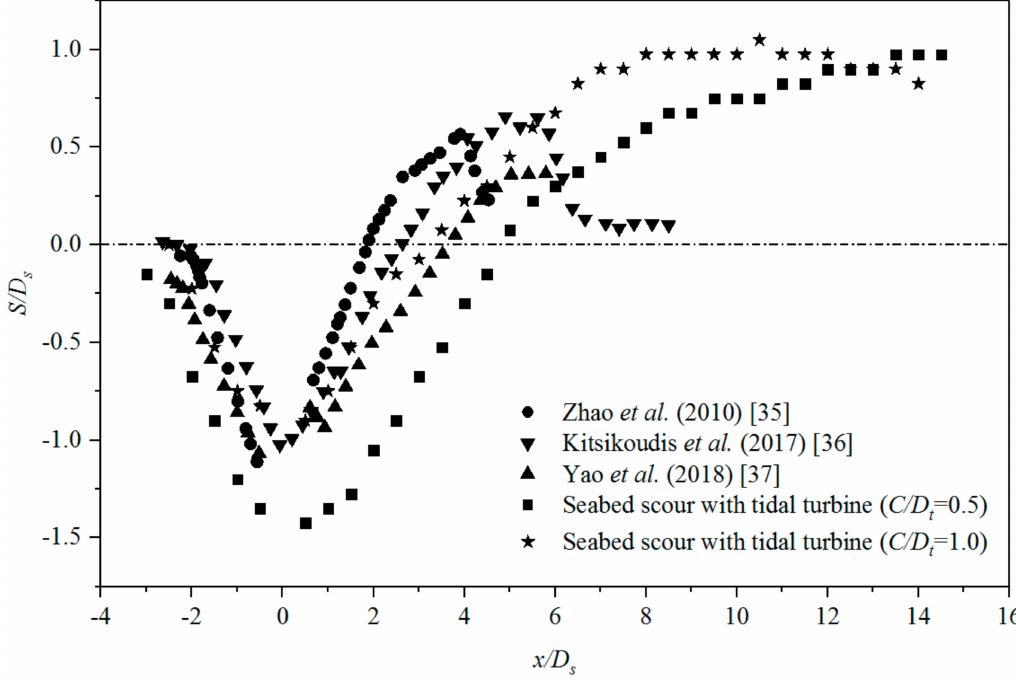
Figure 11. Tidal turbine scouring and cylinder scouring. Table 4. Comparison of tidal turbine scouring and cylinder